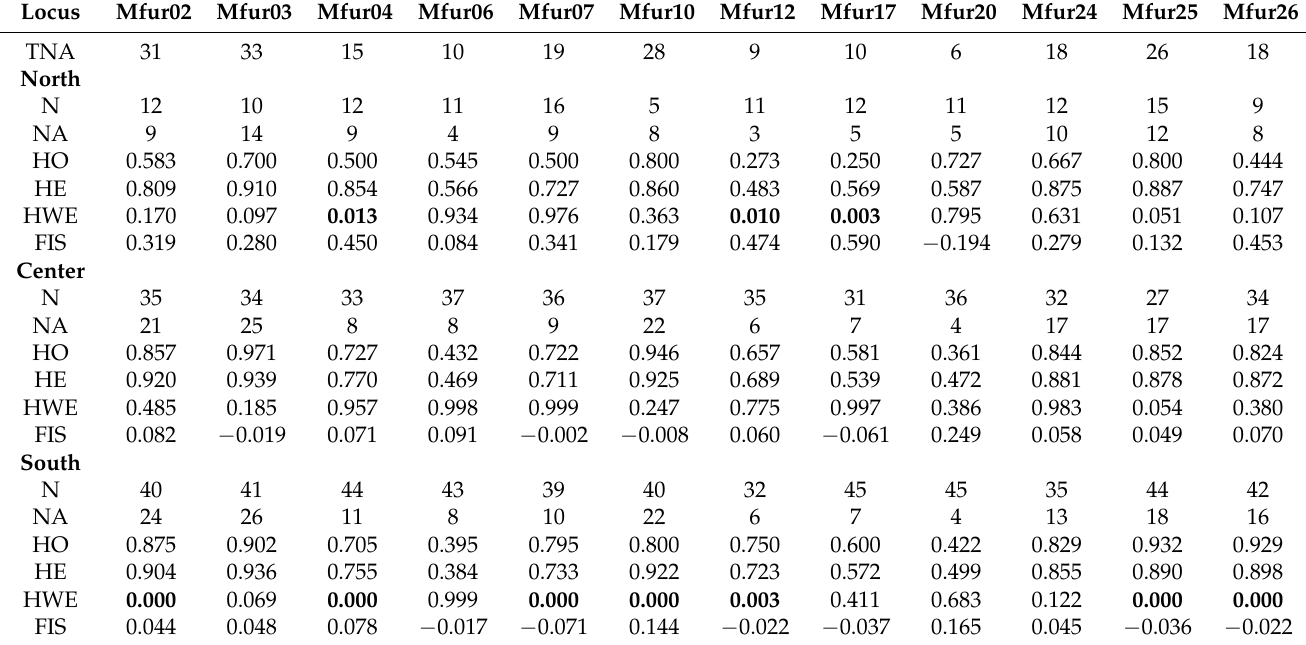
Table 1. Basic statistics of microsatellite diversity in M. furnieri sampled at three sites at Rio de Janeiro State (Brazil). TNA = Total number of alleles at each loci; N = sampled individuals; NA = number of alleles; HO = Observed heterozygosity; HE = Expected Heterozygosity; HWE= Probability values of Hardy-Weinberg Equilibrium; FIS= Inbreeding coefficient estimates.